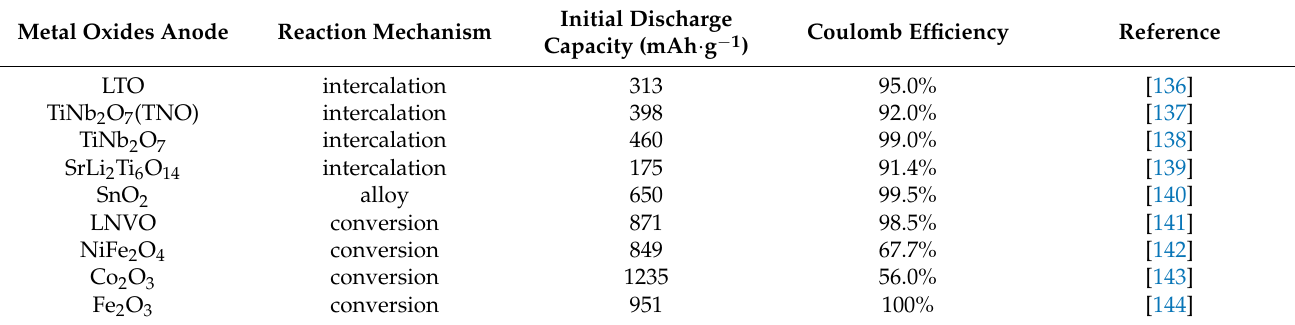
Table 2. Various anode materials for